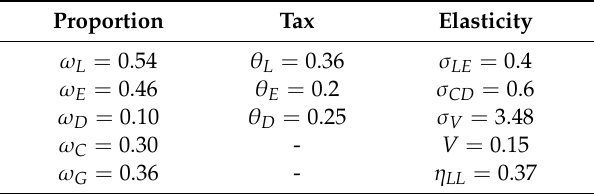
Table 4. Model parameters for